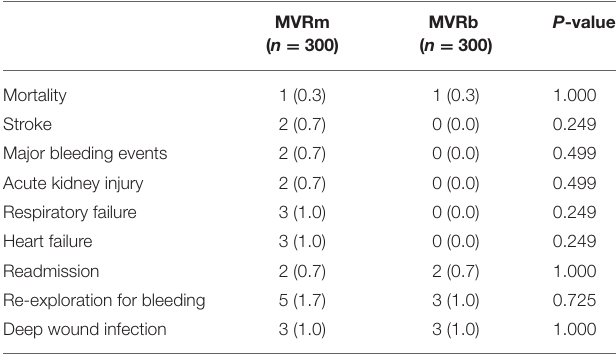
TABLE 3 | In-hospital or 30-day outcomes of mitral valve replacement in patients matched by propensity